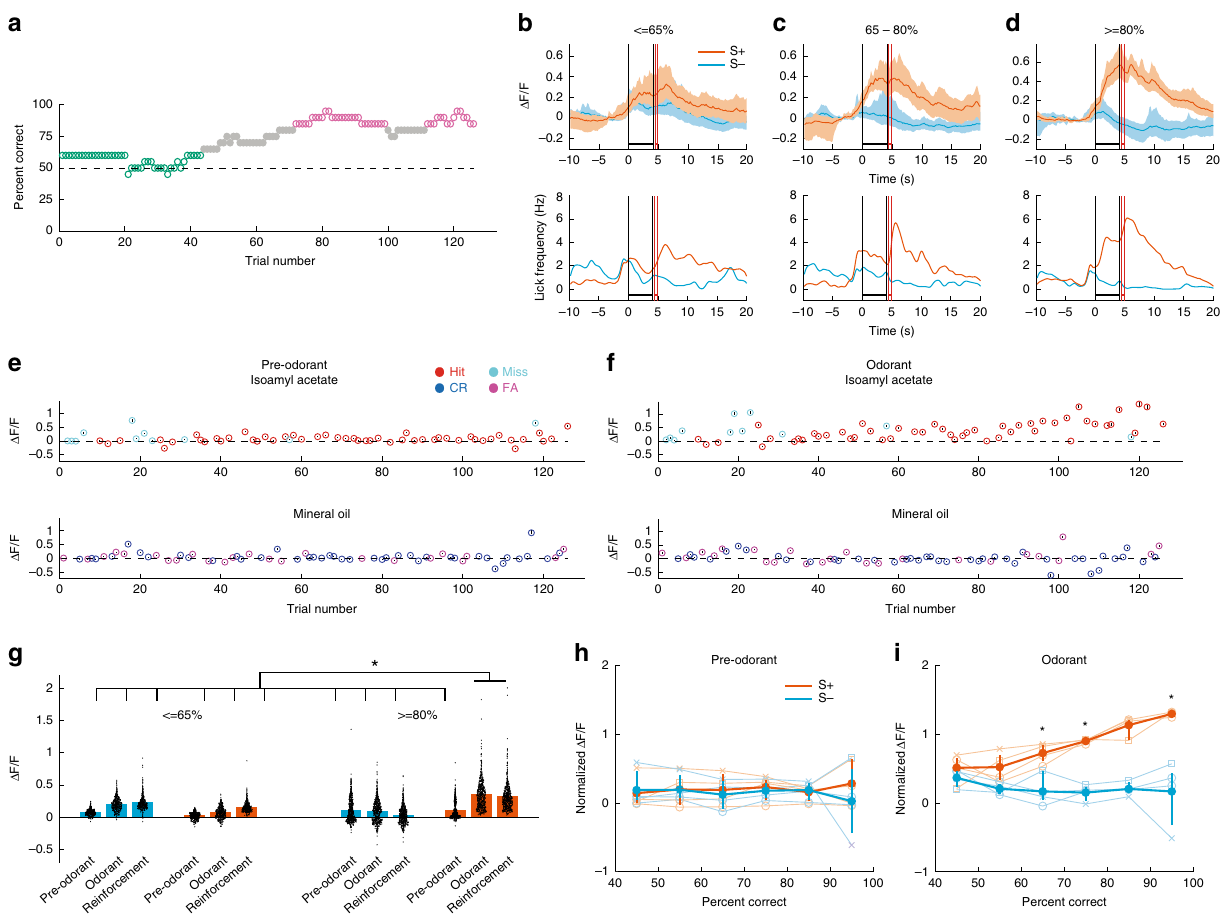
Fig. 2 MLIs developed divergent responses during go – no go learning. a Learning curve for a mouse discriminating 1% Iso from MO in the go – no go task. Magenta dots: pro fi cient level ( ≥ 80% percent correct), green dots: naive level (percent correct ≤ 65%). n = 20 trials within a sliding window. b – d GCaMP6f fl uorescence ( Δ F / F ) time course averaged (mean ± 95% CIs) over all ROIs and trials falling within different pro fi ciency windows shown for the session whose performance is shown in ( a ). b ≤ 65% (naive, 21 trials), c 65 – 80% (12 trials) and d ≥ 80% (pro fi cient, 30 trials), 167 ROIs. Orange: S + , light blue: S − (the shaded area is the 95% CIs). The vertical black lines are odorant onset and removal and the red lines bound the reinforcement period. e , f Per trial Δ F / F averaged (mean ± 95% CIs) over all ROIs for 1 s before odorant application ( e Pre-odorant) and in the last second during odorant application ( f Odorant) shown for the session in ( a ). n = 1 mouse, 167 ROIs. g Violin plot showing per ROI Δ F / F s for the session shown in ( a ) for the following time windows: pre-odorant (1 s before odorant application), odorant (the last second of odorant application) and reinforcement (one and a half seconds after onset of reinforcement). Per ROI Δ F / F s are shown for trials falling within different pro fi ciency windows: ≤ 65% (naive) and ≥ 80% (pro fi cient). A GLM indicates that there are signi fi cant differences between S + (orange) and S − (light blue), between time windows and between naive and pro fi cient mice ( p < 0.001, 5538 d.f., one mouse, *post-hoc ranksum/two-sided t test p value < pFDR = 0.043). h , i . Δ F / F for four mice averaged (mean ± 95% CIs) over all the ROIs for all trials falling within different pro fi ciency windows. Δ F / F average was calculated for 1 s before odorant application ( h ) and for the last second during odorant application ( i ). For the data during odorant application ( i ) GLM analysis indicated that there is a statistical signi fi cance for the interaction between percent correct and the identity of the odorant ( p < 0.001, 43 d.f., n = 4 sessions, 4 mice, GLM F-statistic = 60, p < 0.001). GLM did not yield statistically signi fi cant differences for pre-odorant data ( h p > 0.05, 43 d.f., n = 4 sessions, 4 mice, GLM F-statistic = 0.46, p > 0.05). *Post-hoc two-sided t test, p < pFDR = 0.018. Error bars are 95%